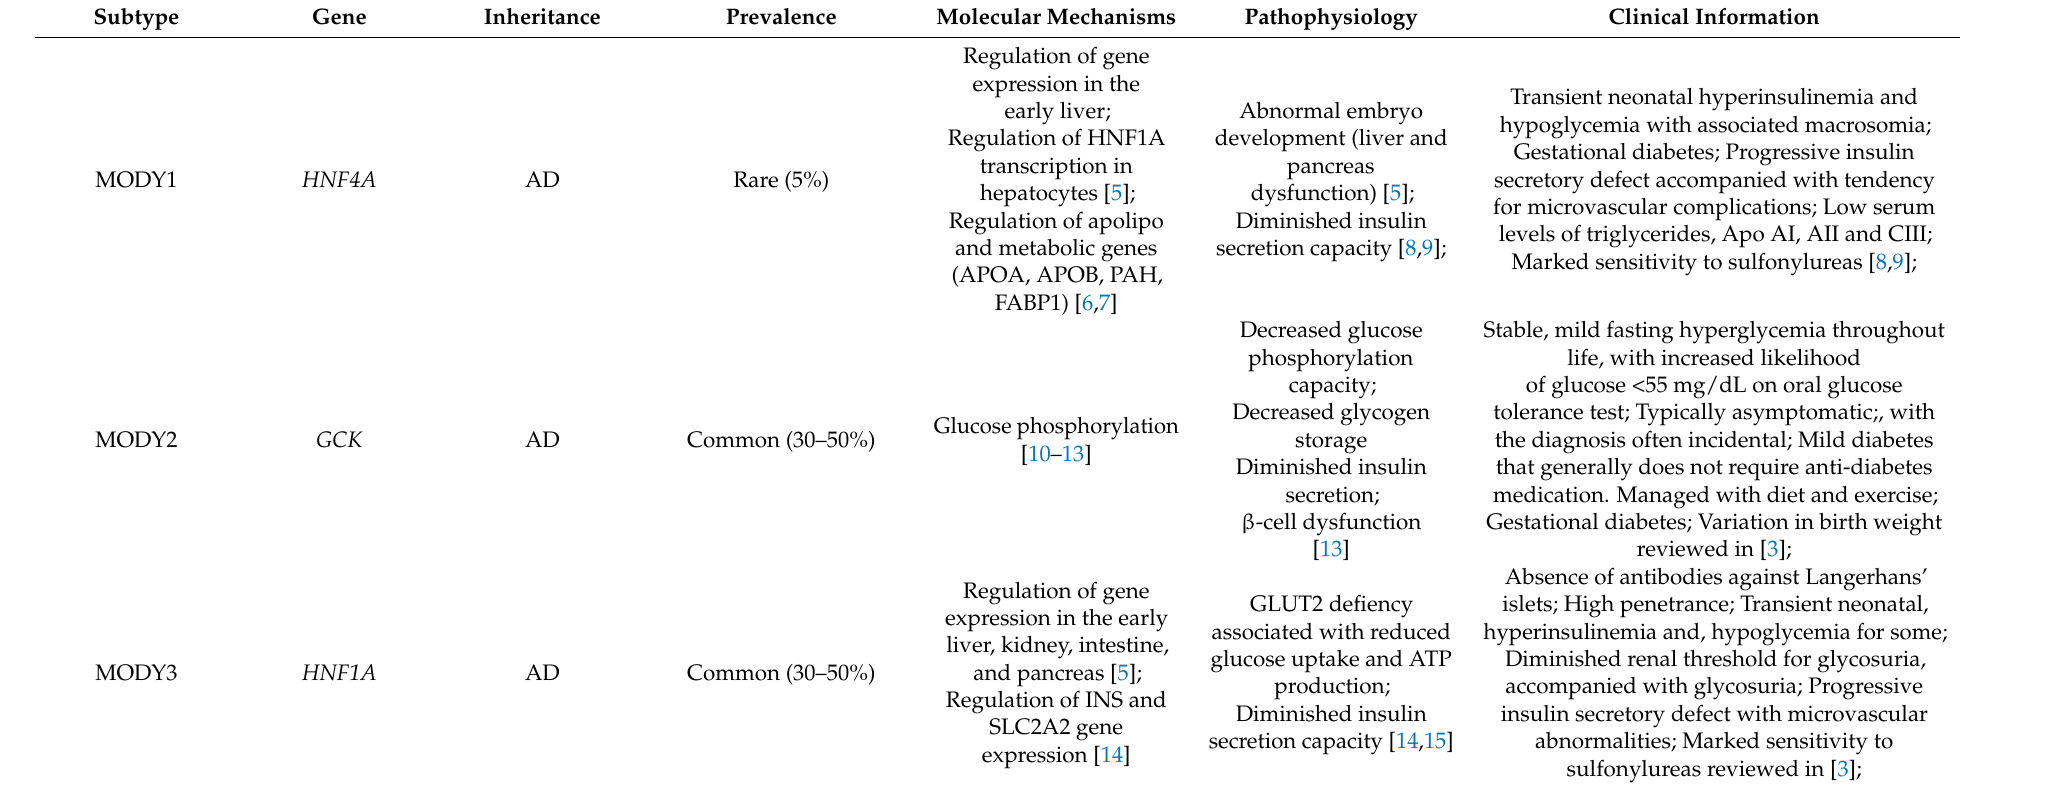
Table 1. Fourteen subtypes of MODY were identified and are currently acknowledged with their related